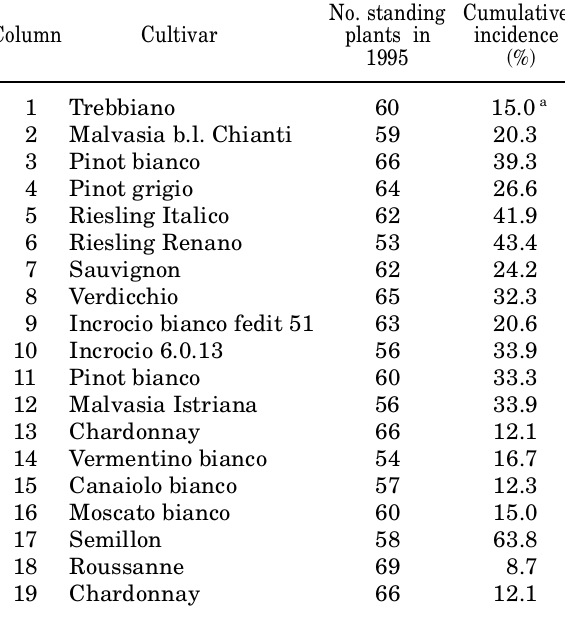
Table 3. Cumulative esca incidence on 17 white-berried cultivars grafted on 140RU outplanted along 19 columns in vineyard CBSI-3. The incidence is the percentage of all plants that exhibited symptoms at least once in the five-year period